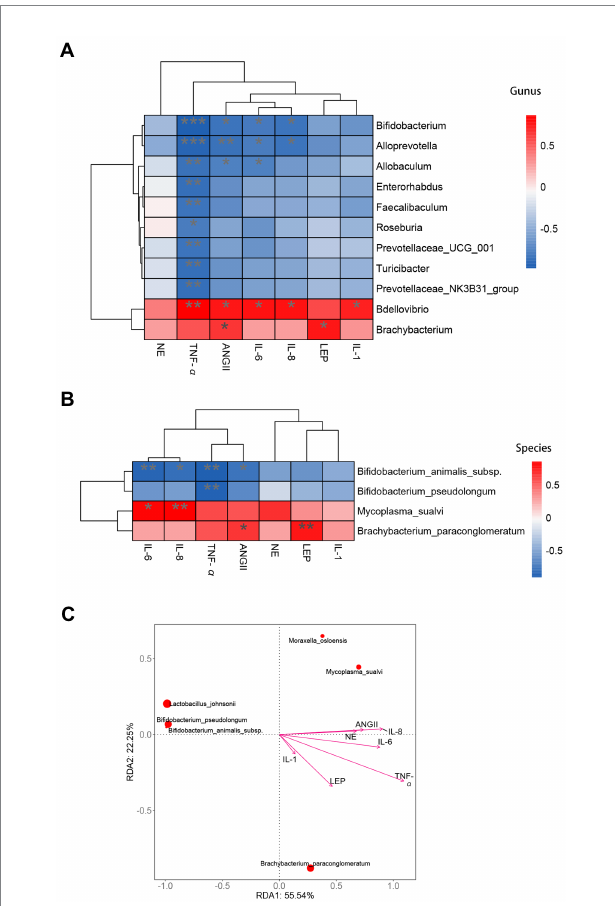
FIGURE 7 Correlation analysis of inflammatory cytokines and hormones with intestinal mucosa microbiota biomarkers associated with hypertension. (A) Heatmap analysis at genus level. (B) Heatmap analysis at species level. (C) RDA analysis at species level. *indicates significant correlation,** and *** indicate that the correlation is highly